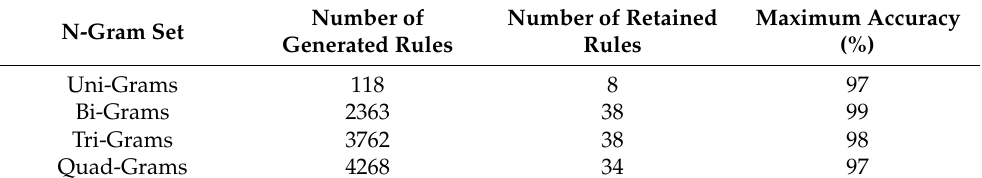
Table 1. Number of generated and retained bi-gram rules and associated accuracy.